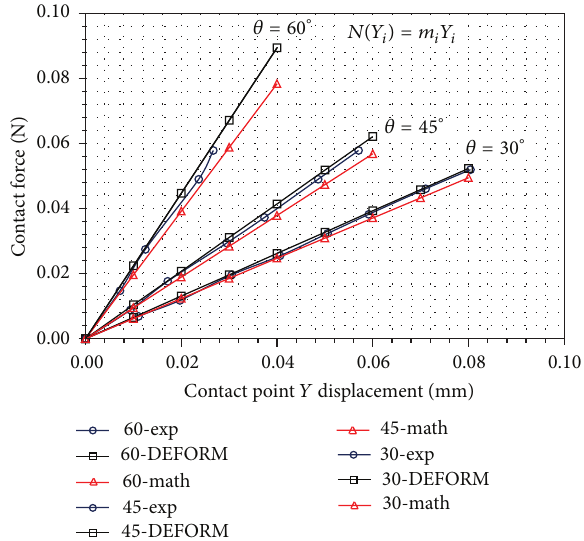
Figure 11: Comparison of simulation and mathematical model.